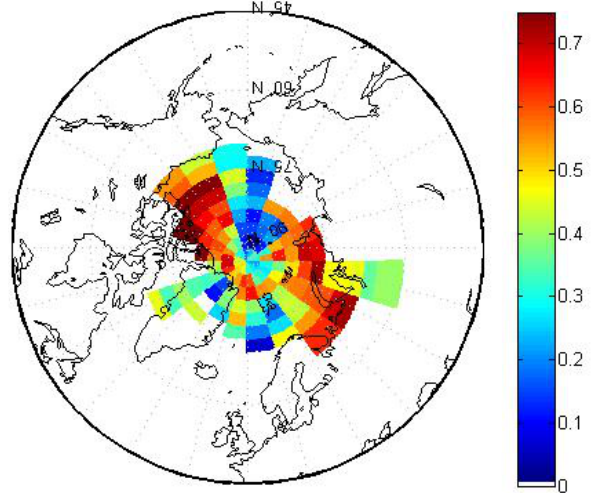
Fig. 13. PSCF analysis of the Organic